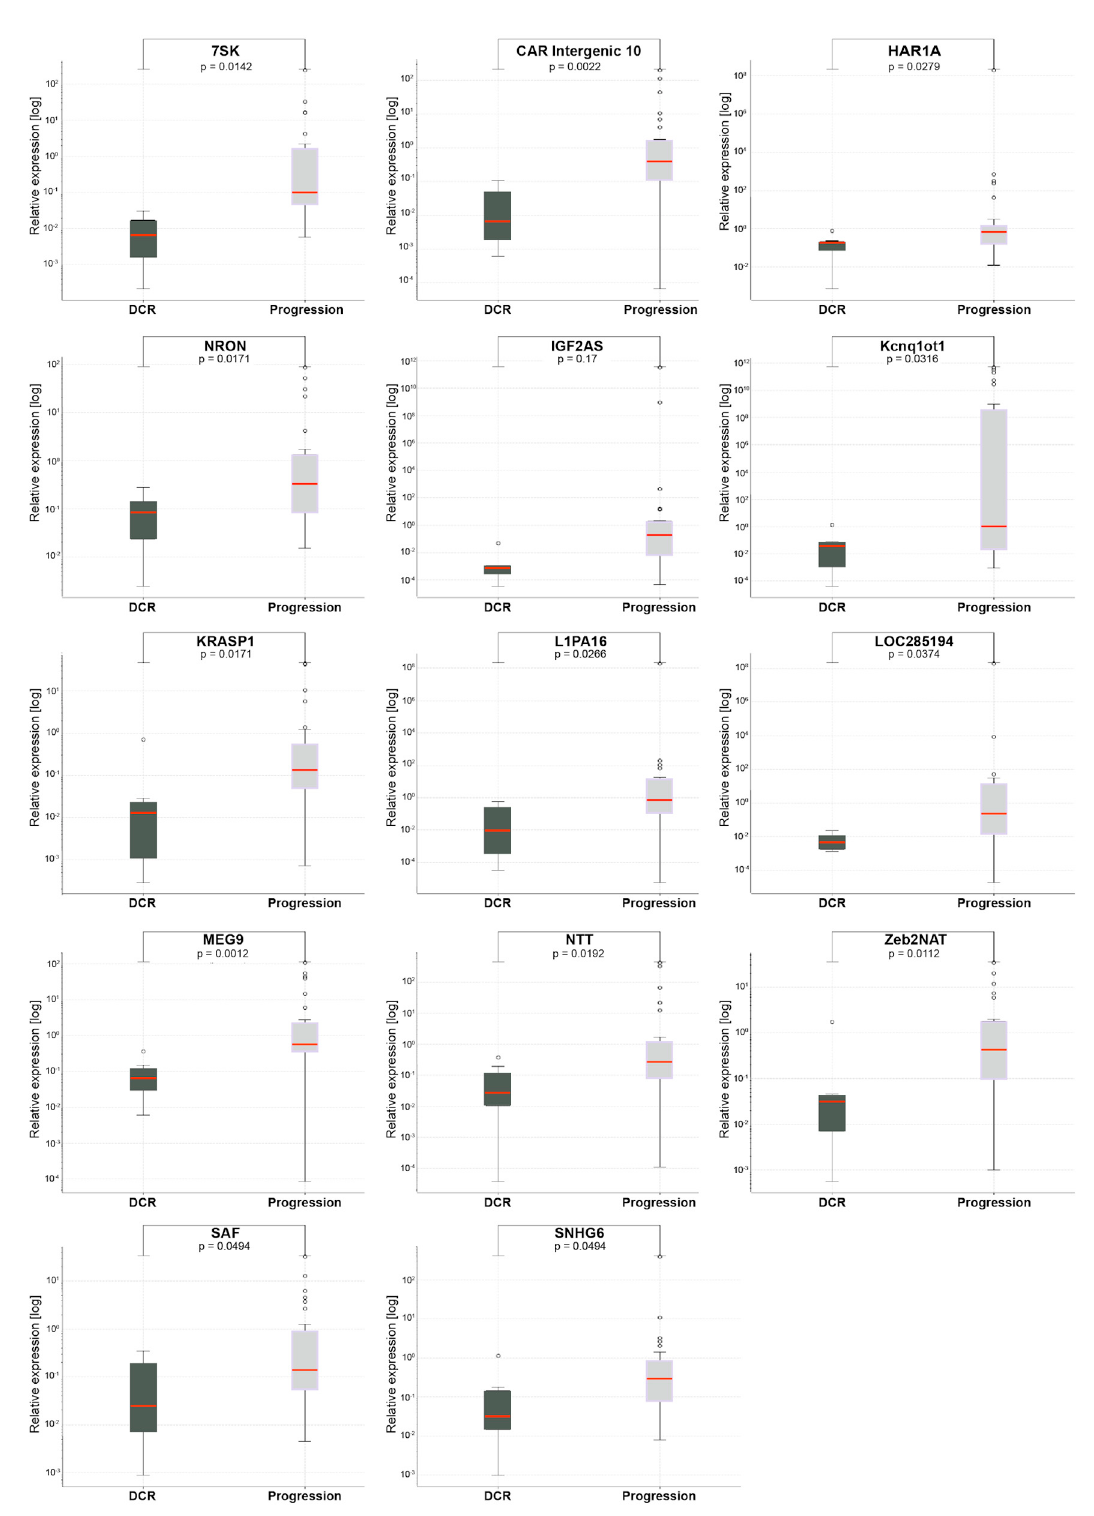
Figure 5. lncRNA expressions in HNSCC patients receiving palliative chemotherapy according to response to treatment (disease control rate vs. progression). Data present median expression of lncRNA with confidence interval (CI); p < 0.05.